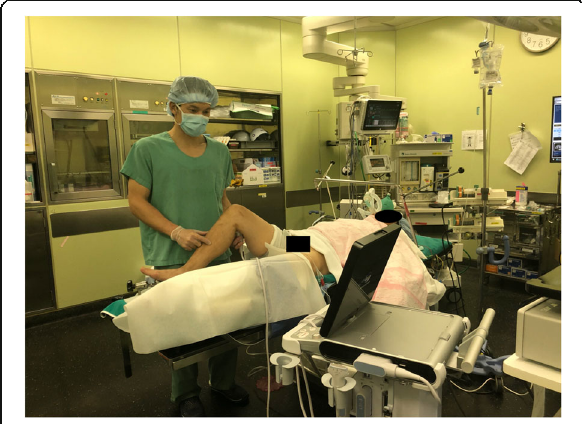
Fig. 1 Preoperative setting and ultrasound evaluation in